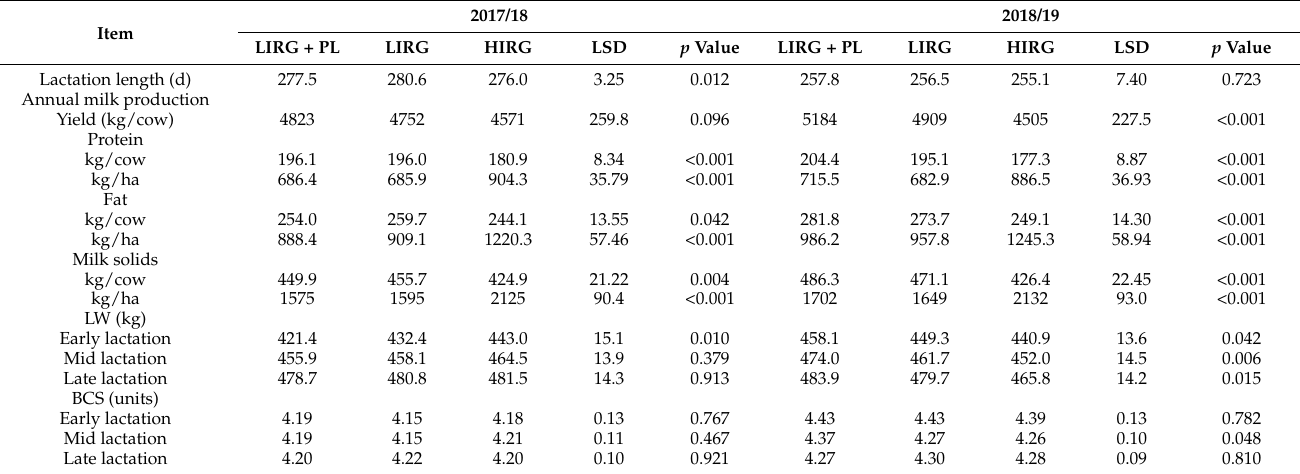
Table 4. Lactation length, annual milk yield, milk solids (sum of fat and protein), fat, and protein production, and live weight (LW) and body condition score (BCS; 1–10 scale) values averaged within early ( ≤ 100 days in milk), mid (>100 and ≤ 200 days in milk), and late (>200 days in milk) stage of lactation of dairy cows grazing ryegrass and plantain-based swards in a lower input system (3.5 cow/ha stocking rate and herbage received 150 kg nitrogen/ha/year; LIRG + PL), perennial ryegrass–white clover mix sward in a lower input system (3.5 cow/ha and herbage received 150 kg nitrogen/ha/year; LIRG), or perennial ryegrass–white clover mix sward in a higher input system (5 cow/ha and herbage received 300 kg nitrogen/ha/year; HIRG) in 2017/18 and 2018/19 milking